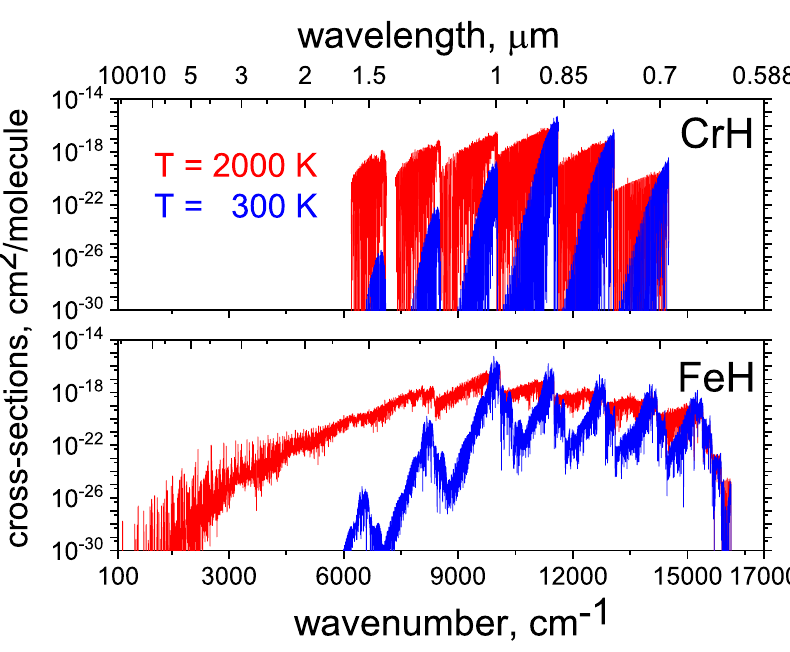
Figure 8. Absorption cross sections of CrH from Chowdhury et al. [43] and FeH from Dulick et al. [104]. 2.14. C